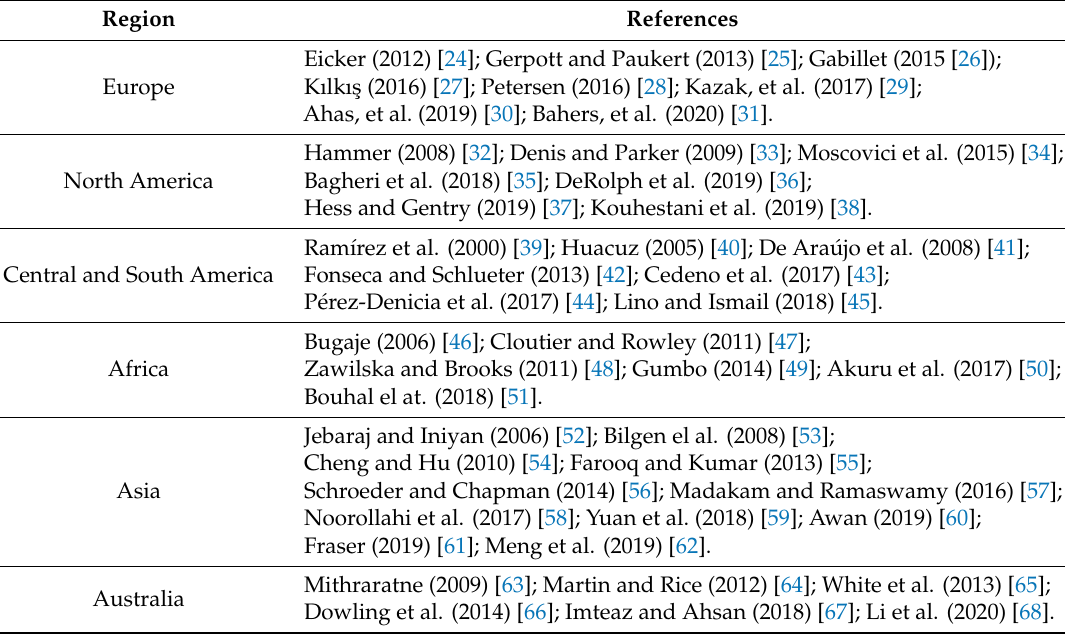
Table 1. Research on renewable energy sources in cities and regions